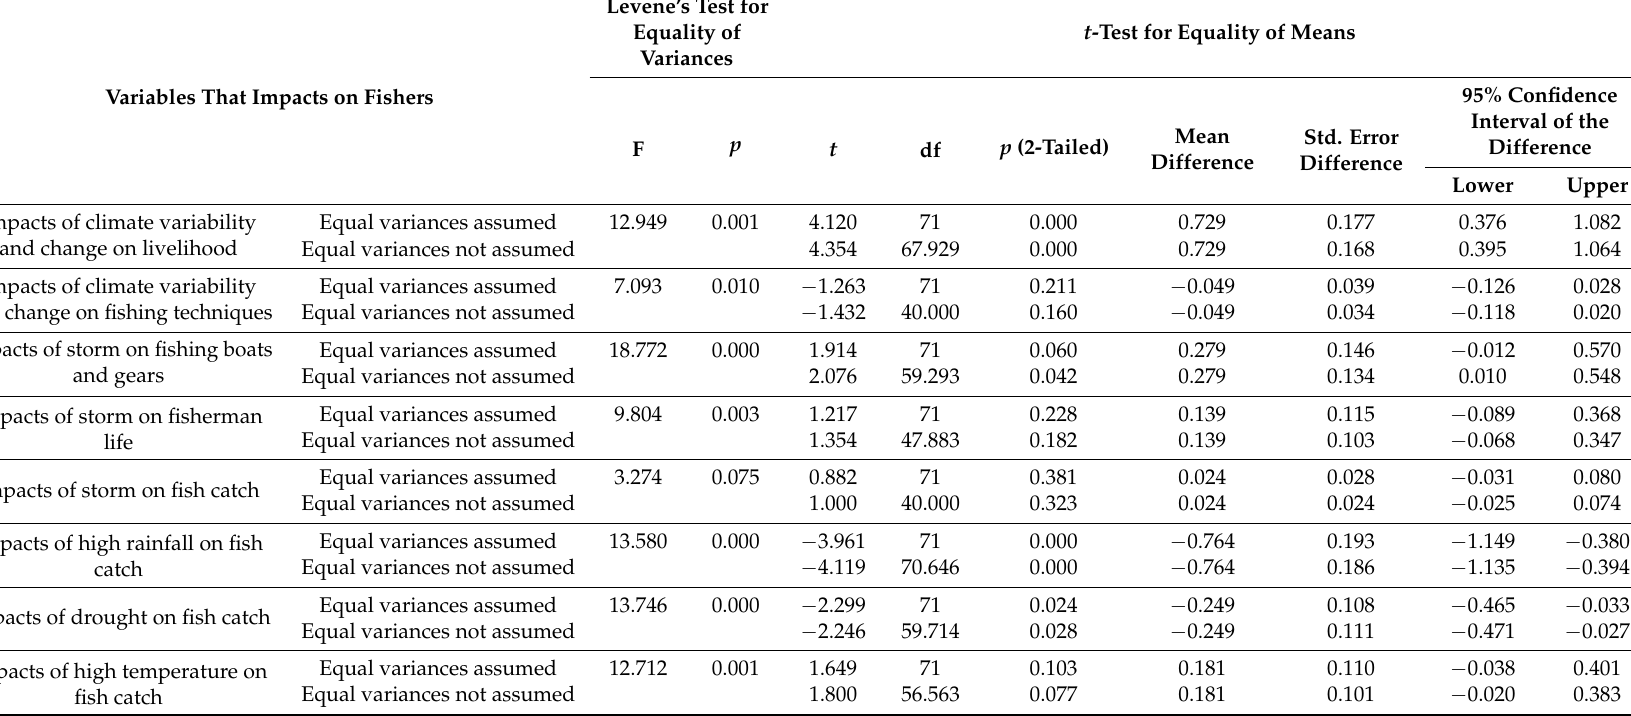
Table 3. Impacts of different hazards on the migrant and non-migrants’ fishing